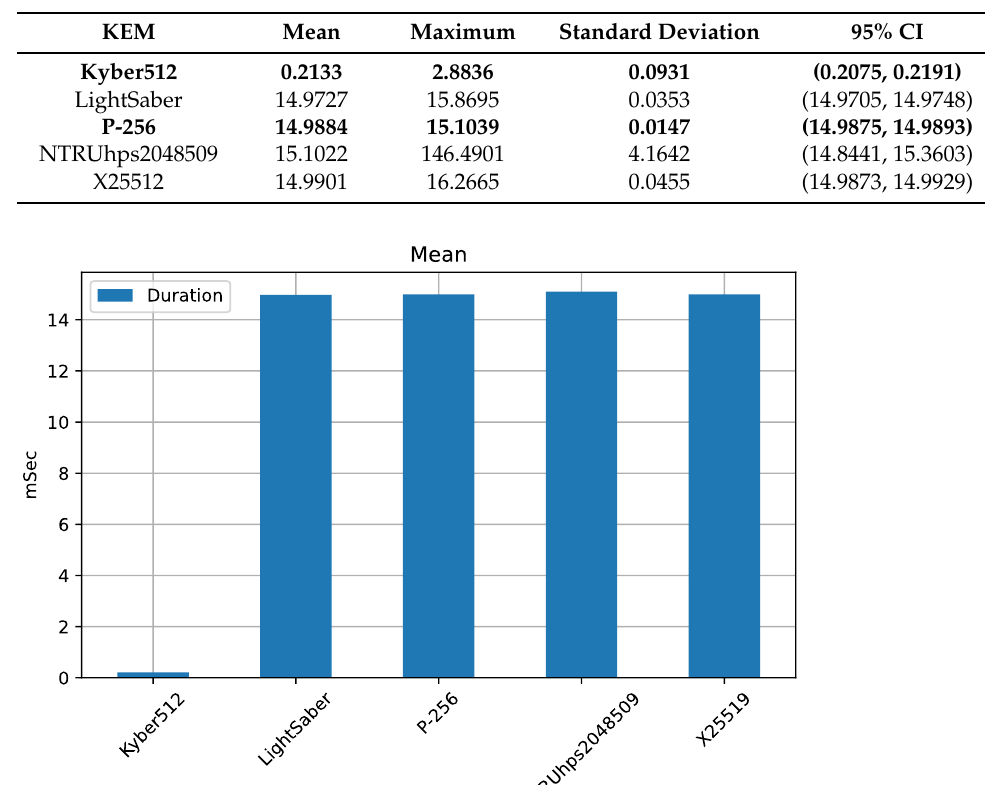
Table 10. Statistics on the connection durations, for a better appreciation of its behavior. The best performing is Kyber512, followed by the elliptic curves. The worst is NTRUhps2048509, followed by LightSaber.